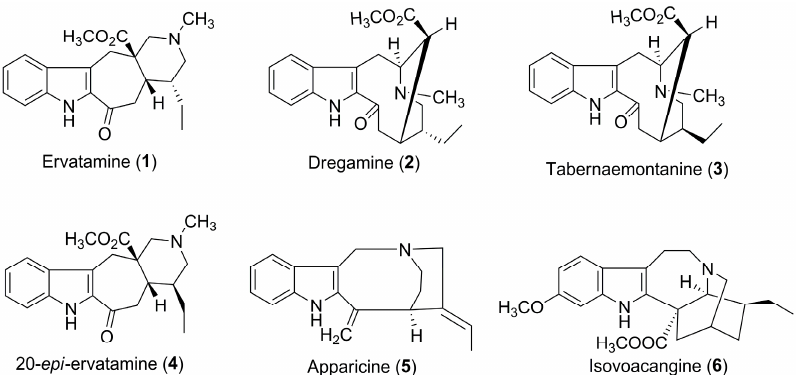
Figure 1. Chemical structures of monoterpenoid indole alkaloids (MIAs) from E. yunnanensis.